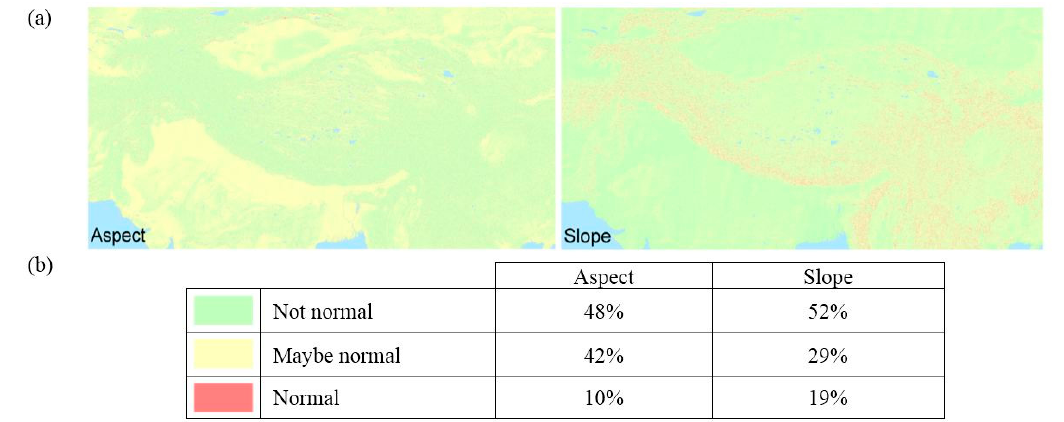
Figure 4. Slope and aspect sub-pixel normality distribution maps ( a ) and statistics ( b ) within each square kilometer pixel over the Tibetan Plateau and the